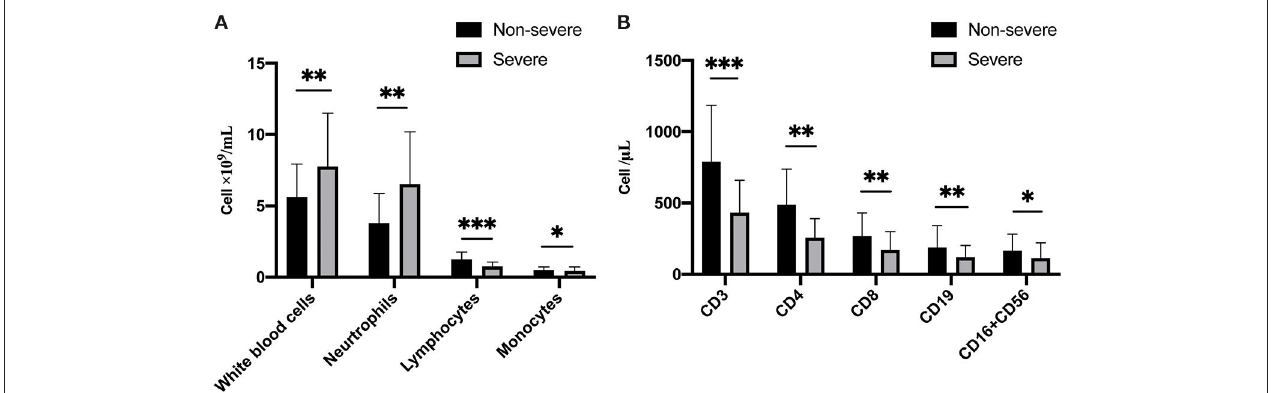
FIGURE 2 | Comparison of immune cells between non-severe and severe patients. (A) The total number and types of white blood cells are different between non-severe and severe patients. (B) The counts of leukocyte classified by differentiation antigen are different between non-severe and severe patients.